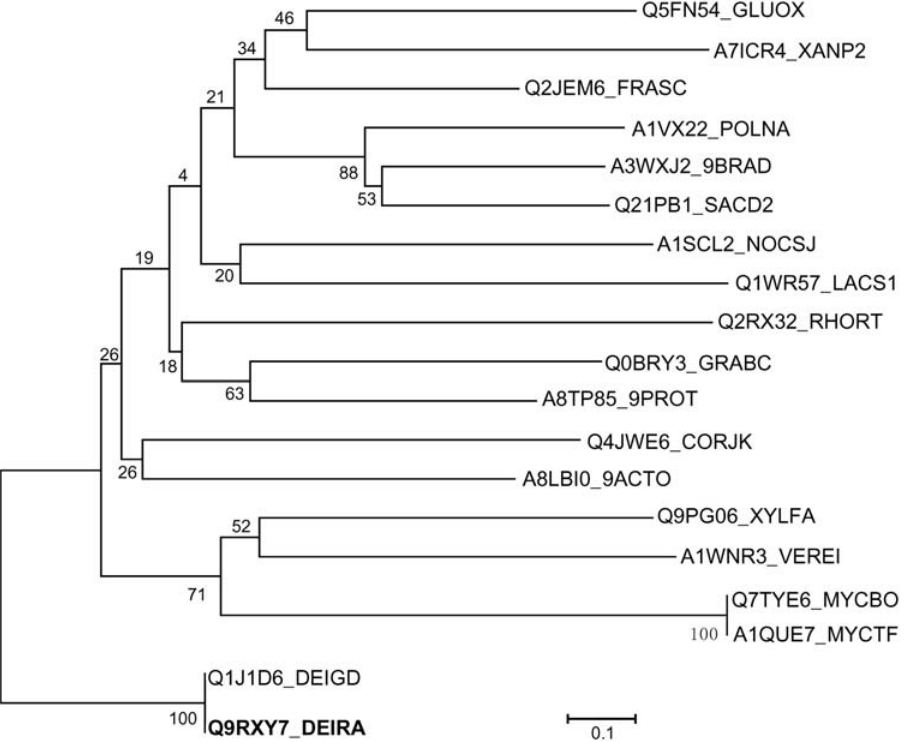
Figure 7. Unrooted neighbour-joining phylogenetic tree from the alignment of the D.radiodurans R1 IrrE protein with related proteins. Bootstrap values based on 1000 replications are listed as percentages at branching point. Bar, 0.1 substitutions per position. The sequence abbreviations, species and functional descriptions are as follows: Q9RXY7_DEIRA, Deinococcus radiodurans R1, IrrE; Q1J1D6_DEIGD, Deinococcus geothermalis DSM 11300, Zn dependent hydrolase fused to HTH domain, IrrE ortholog; Q5FN54_GLUOX, Gluconobacter oxydans , Transcriptional regulator; Q9PG06_XYLFA, Xylella fastidiosa , Putative uncharacterized protein; Q0BRY3_GRABC, Granulibacter bethesdensis ATCC BAA-1260, Putative uncharacterized protein; A1VX22_POLNA, Polaromonas naphthalenivorans CJ2, Putative uncharacterized protein; A7ICR4_XANP2, Xanthobacter autotrophicus ATCC BAA-1158, Putative uncharacterized protein; Q2JEM6_FRASC, Frankia sp. CcI3, Putative uncharacterized protein; A1SCL2_NOCSJ, Nocardioides sp. BAA-499, Helix-turn-helix domain protein; A8TP85_9PROT, Alpha proteobacterium BAL199, Putative uncharacterized protein; A1WNR3_VEREI, Verminephrobacter eiseniae EF01-2, Putative uncharacterized protein; Q1WR57_LACS1, Lactobacillus salivarius subsp. salivarius UCC118, Transcriptional regulator; Q2RX32_RHORT, Rhodospirillum rubrum ATCC 11170, Putative uncharacterized protein; A3WXJ2_9BRAD, Nitrobacter sp. Nb-311A, Putative uncharacterized protein; Q4JWE6_CORJK, Corynebacterium jeikeium K411, Putative uncharacterized protein; Q21PB1_SACD2, Saccharophagus degradans ATCC 43961, Putative uncharacterized protein; Q7TYE6_MYCBO, Mycobacterium bovis , Putative uncharacterized protein Mb2544c; A1QUE7_MYCTF, Mycobacterium tuberculosis F11, Putative uncharacterized protein; A8LBI0_9ACTO, Frankia sp. EAN1pec, Putative uncharacterized